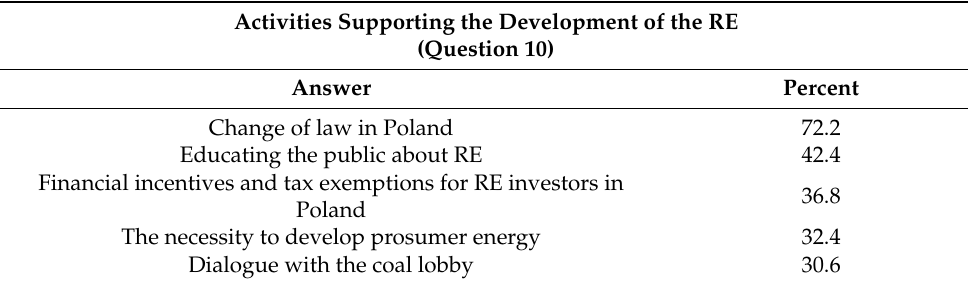
Table 9. Activities supporting the development of the RE sector in